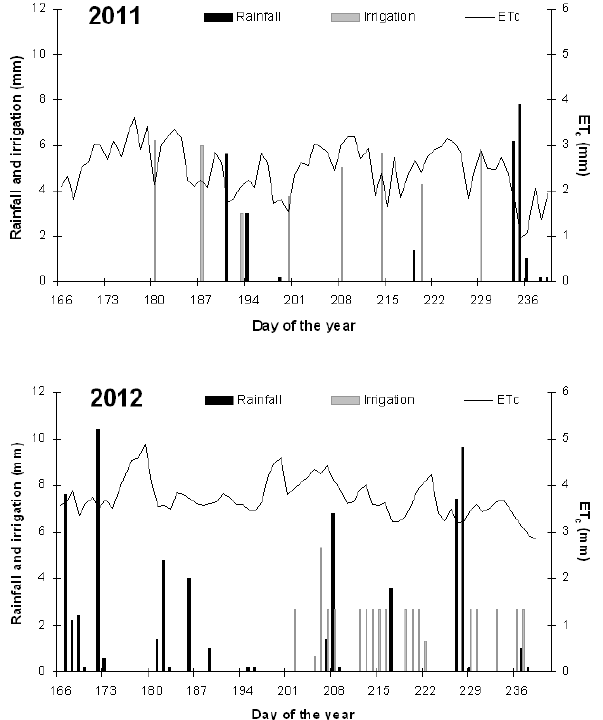
Figure 2. Crop evapotranspiration (ET c ), rainfall and irrigation wa- ter applied over the two growing seasons studied, 2011 and 2012. Day of the year 166 is 14 June.